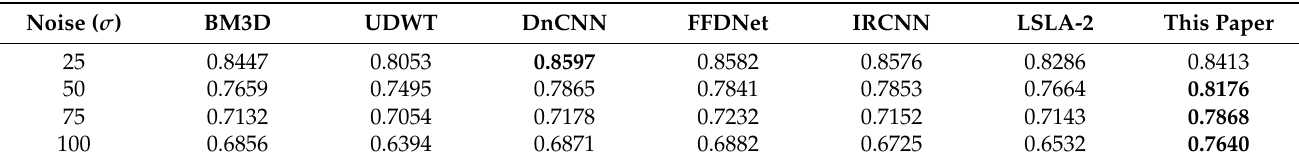
Table 2. SSIM values of the different